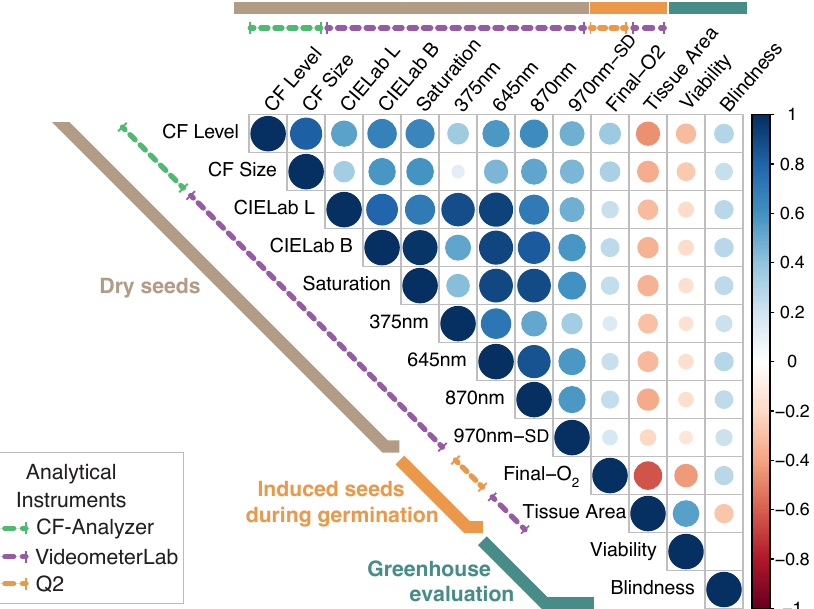
Figure 11. Pearson correlation matrix of selected main parameters (Table 1) from the CF Analyzer (rows and columns 1–2, dashed green), the VideometerLab (rows and columns 3–9 and 11, dashed purple) the Q2 respirometer (row and column 10, dashed orange) and greenhouse tests (rows and columns 12–13) for all induced seeds. Parameters are also organized in the order they were captured in the different stages of the study: dry seeds (rows and columns 1–9, brown bars), induced seeds during germination (rows and columns 10–11, orange bars) and in the greenhouse (rows and columns 12–13, green bars). The Pearson correlation coefficients between the row and column parameters are graphically displayed as circles; their size and color shadings indicate the strength of the correlation coefficients from 0 to 1 for a positive relation (blue color) or 0 to − 1 for a negative relation (red color) (only correlation coefficients with significance level for p values below 0.01 are